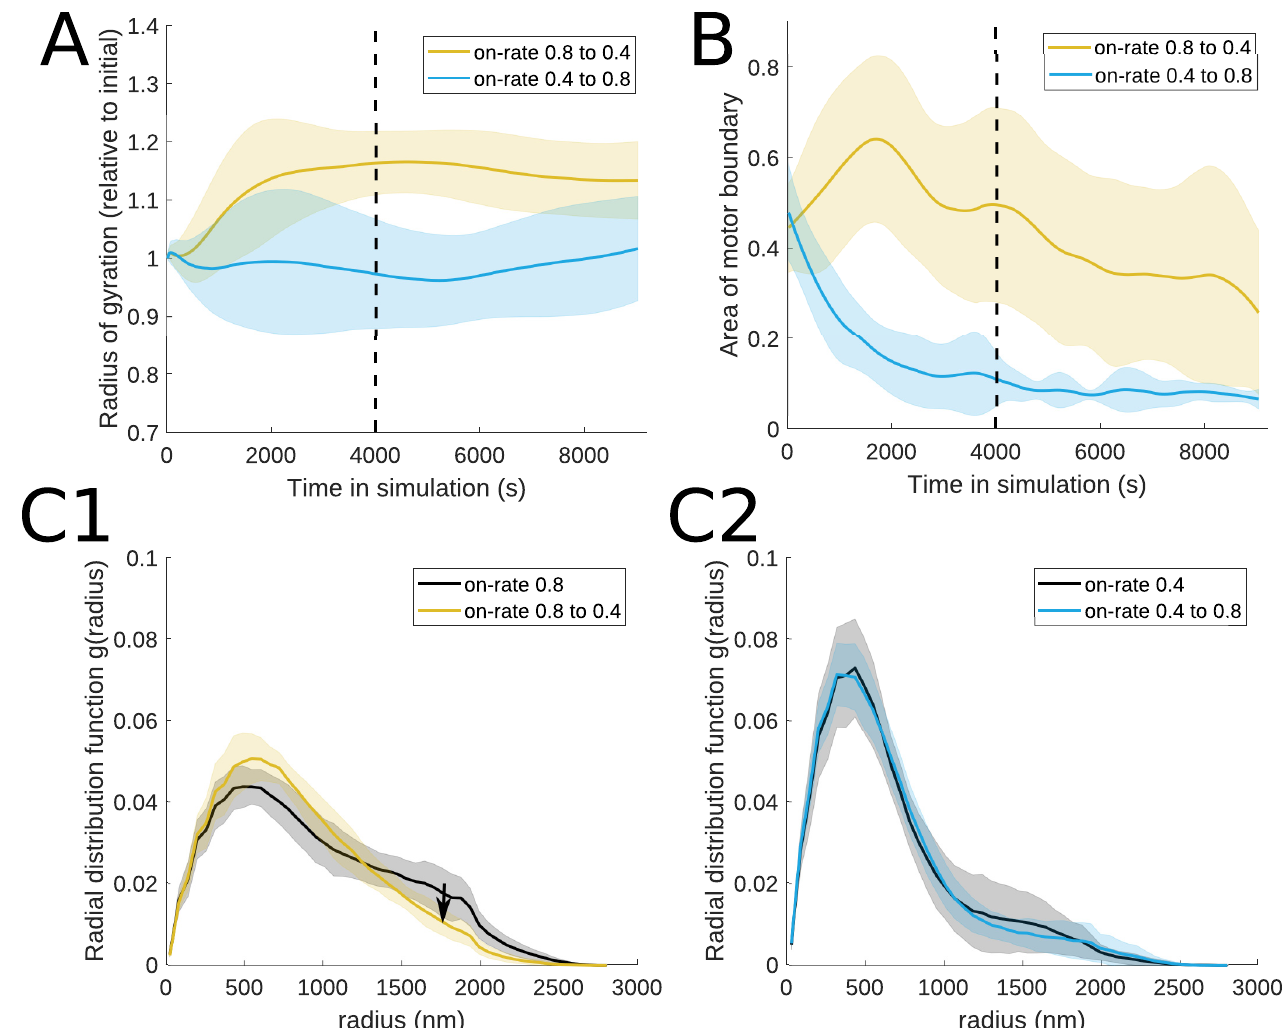
Fig 11. Time-dependent change in motor protein binding rate results in asymmetric changes in actin filament organization. Changing the myosin motor binding rate at 4000 s and its effect on (A) actomyosin network contractility, (B) motor spread, and (C) radial distribution function results in actin filament organization that depends on the order in which the motor proteins interact with the actin meshwork. The dashed vertical lines in A-B indicate the time when the on-rate parameter changes in the simulation. Both panels of (C) indicate the distribution of monomer distances at 4000 s in black and the distribution of distances after the parameter change, at 9000 s, in the colors consistent with panels A-B. The parameter values used are d step = 6 nm, F s = 100 pN, range heads = 15–30 (see Table 1). Solid lines indicate the average and shaded areas indicate the standard deviation over 10 independent stochastic